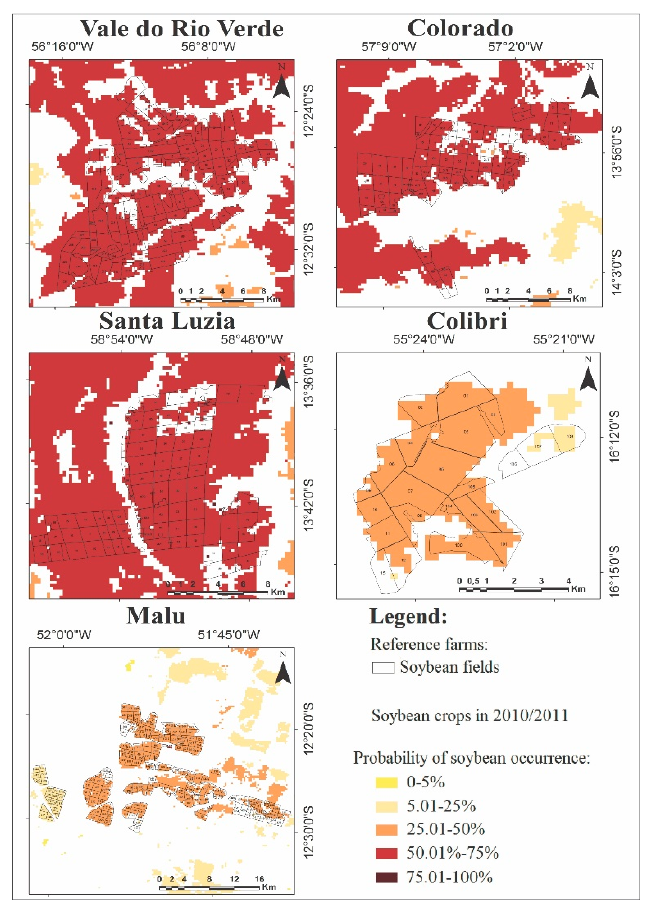
Figure 9. Spatial distribution of the probability of soybean occurrence in the agglomerates Vale do Rio Verde, Colorado, Santa Luzia, Colibri, and Malu in the 2010/2011 crop season.